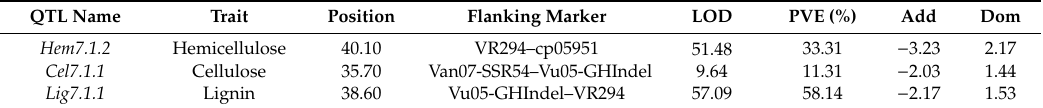
Table 2. Locations and e ff ects of QTLs identified for pod fiber contents in F 2 population F2B of the cross JP81610 × TVnu-457 by inclusive composite interval mapping .